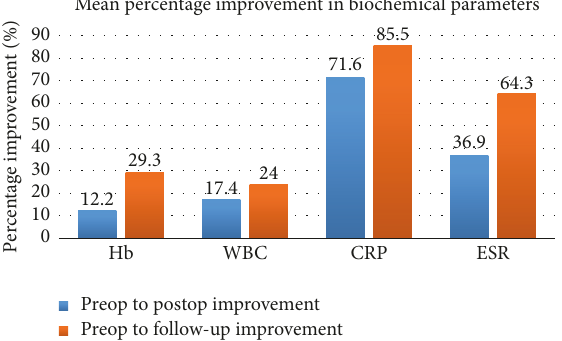
Figure 3: Mean percentage improvements in all the measured